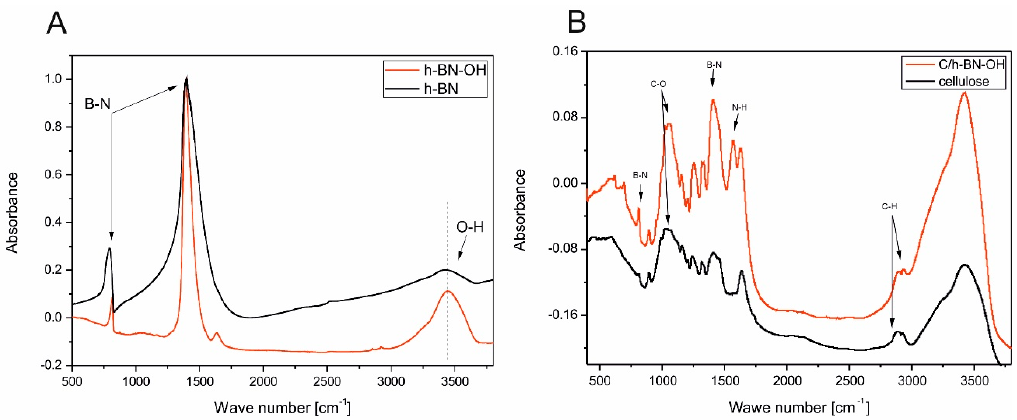
Figure 5. FT-IR spectra of: h-BN nanosheets ( A ) before (black curve) and after (red curve) the oxidation process and cellulose fibers ( B ) before (black curve) and after (red curve) the functionalization with h-BN-OH.